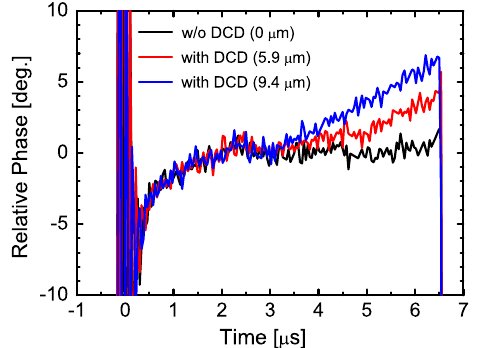
FIG. 4. Measured bunch phase variation with different DCD parameters. The starting time of DCD is approximately 3 μ s in the macropulse and the amounts of the phase modulation correspond to cavity detunings of 5 . 9 μ m and 9 . 4 μ m from the unmodulated condition.